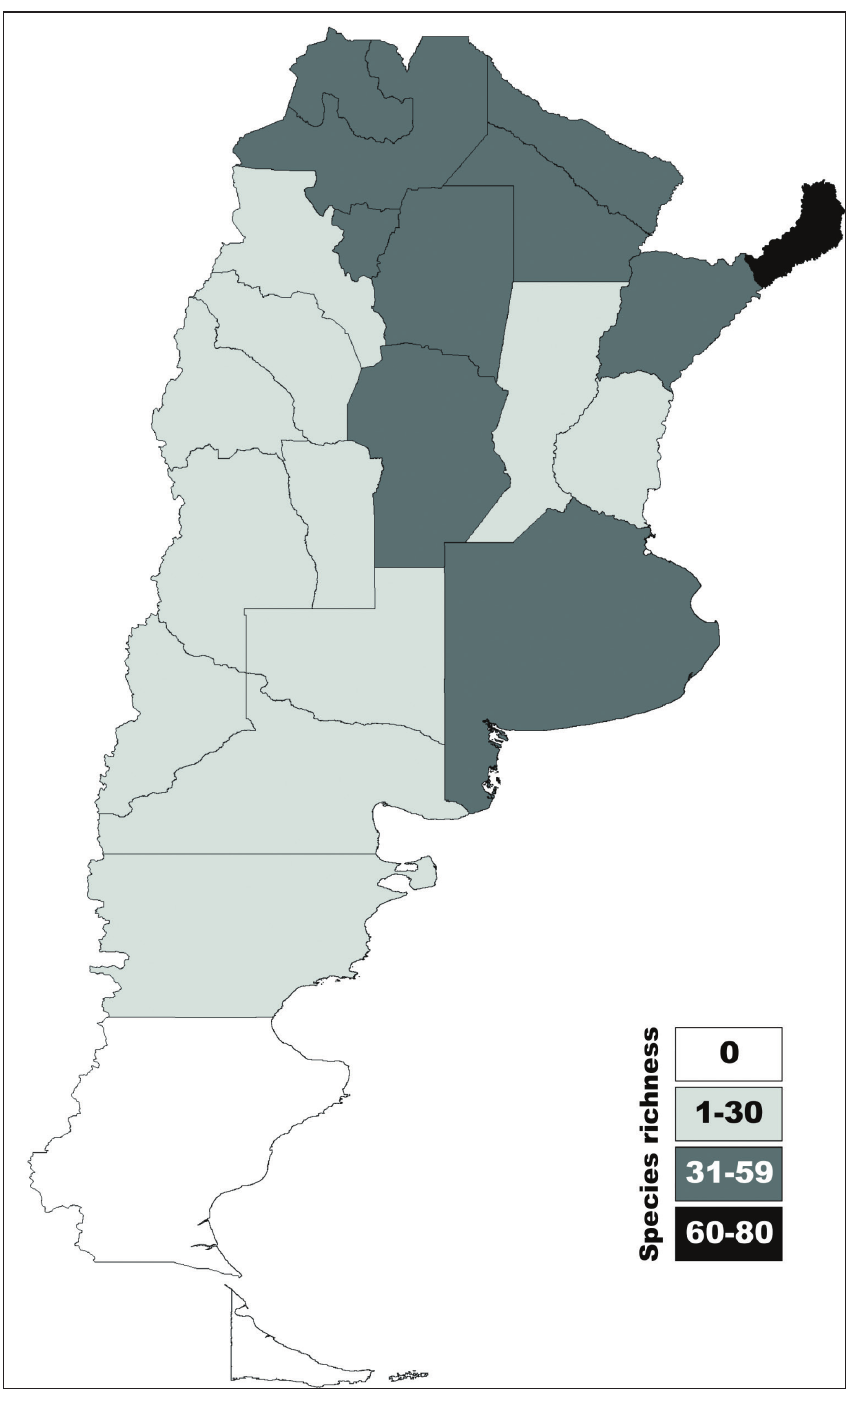
Figure 36. Map indicating species number (0–80) (richness) by